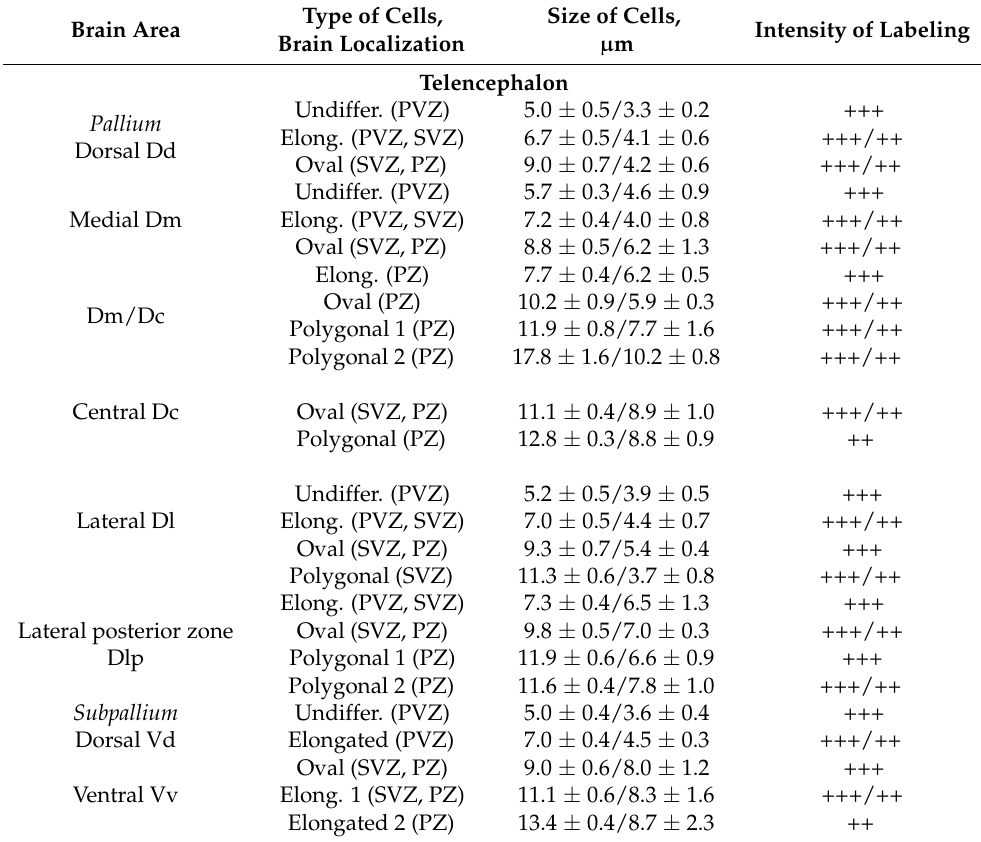
Table 4. Morphometric and densitometric parameters (M ± SD) of nestin-immunopositive cells in the telencephalon and optic tectum of trout, Oncorhynchus mykiss